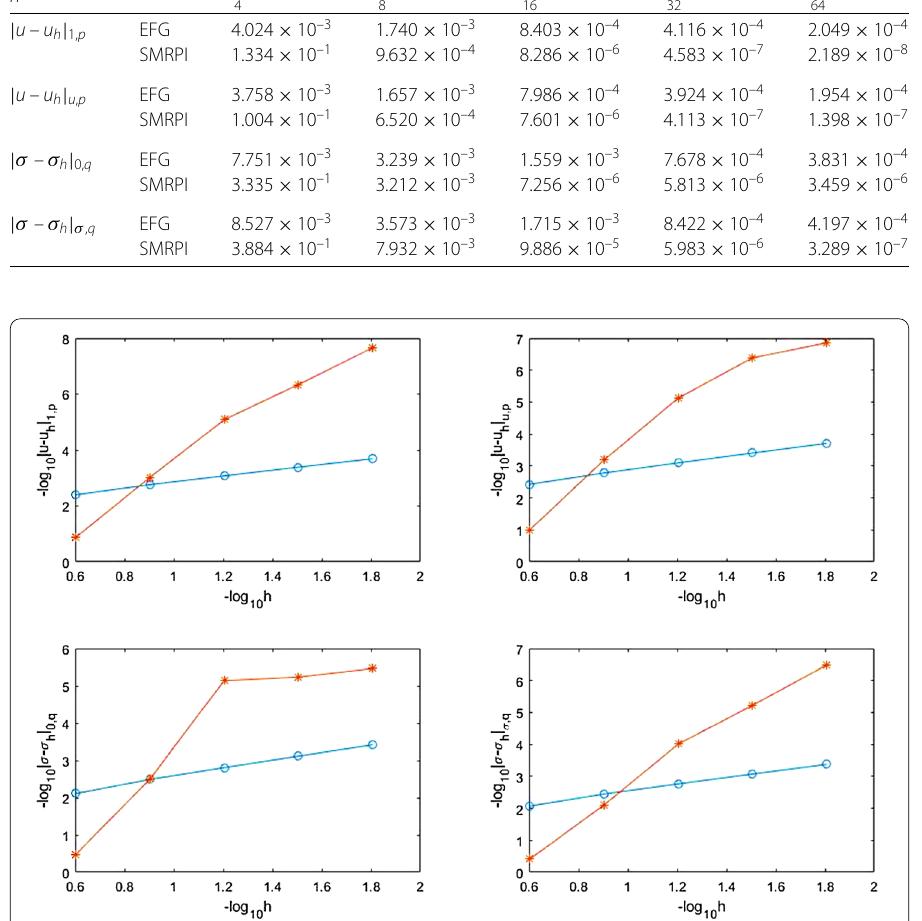
Figure 3 Comparison the errors of SMRPI (red line) and EFG (blue line) solutions with different choices of h for Example 1